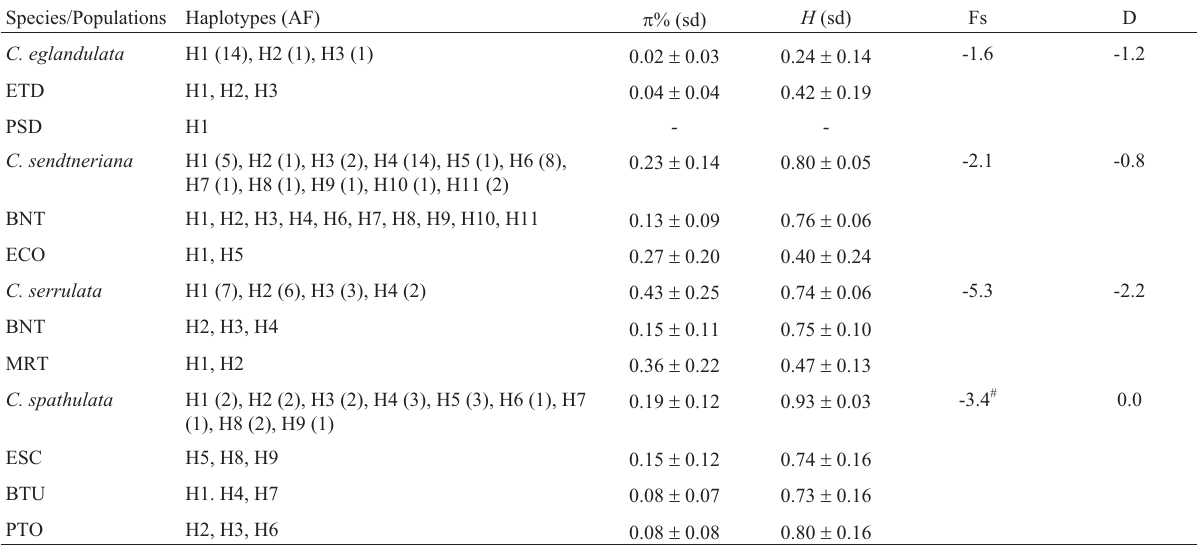
Table 2 - Genetic variability and populations based on concatenated trnH - psbA / trnS - trnG for four Calibrachoa species . Species/Populations Haplotypes